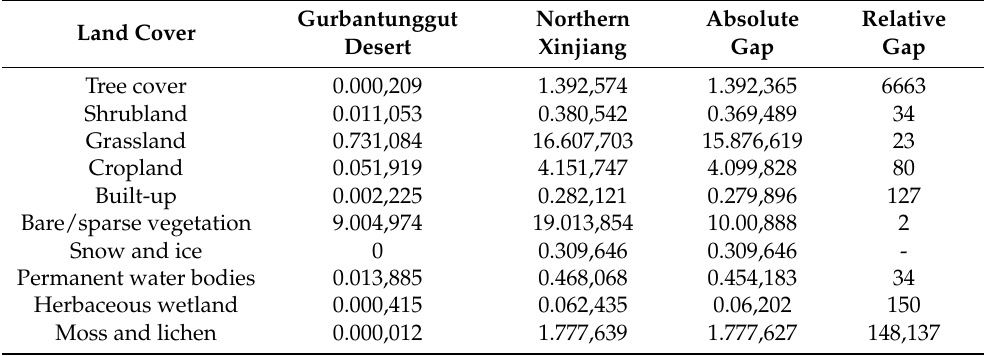
Table 1. Gap analysis of land use/land cover in Gurbantunggut Desert area in northern Xinjiang in 2020 (unit: 10 4 km 2